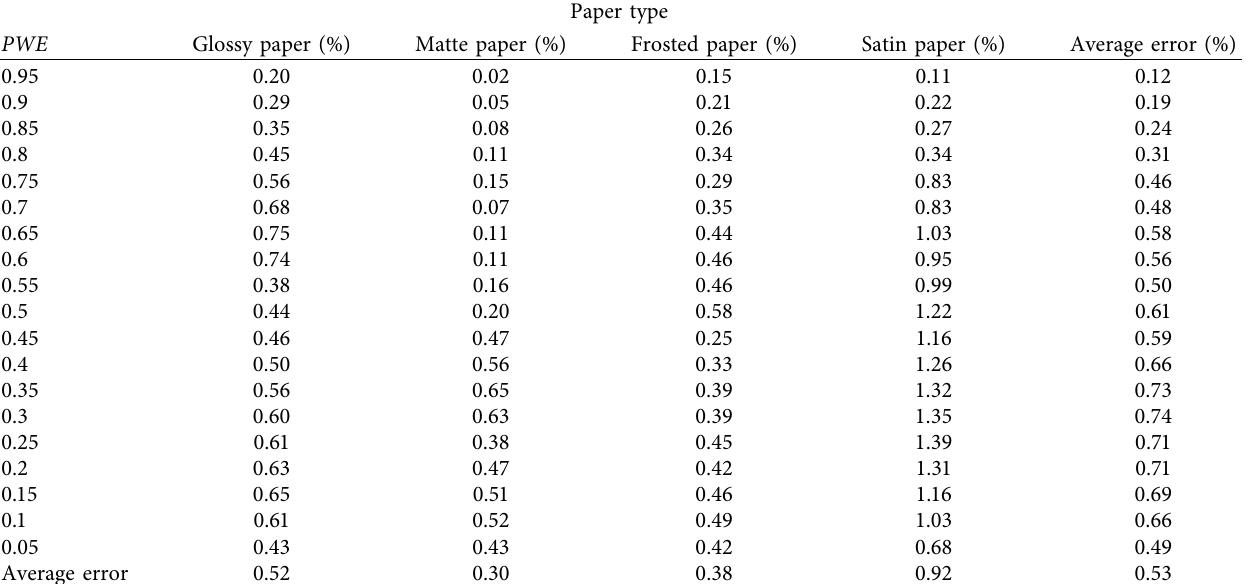
Figure 6: Relationship between the proportion of white endmembers on different photo papers and the RMSE of the unmixing error. Table 3: Statistics of mixed pixel linear unmixing